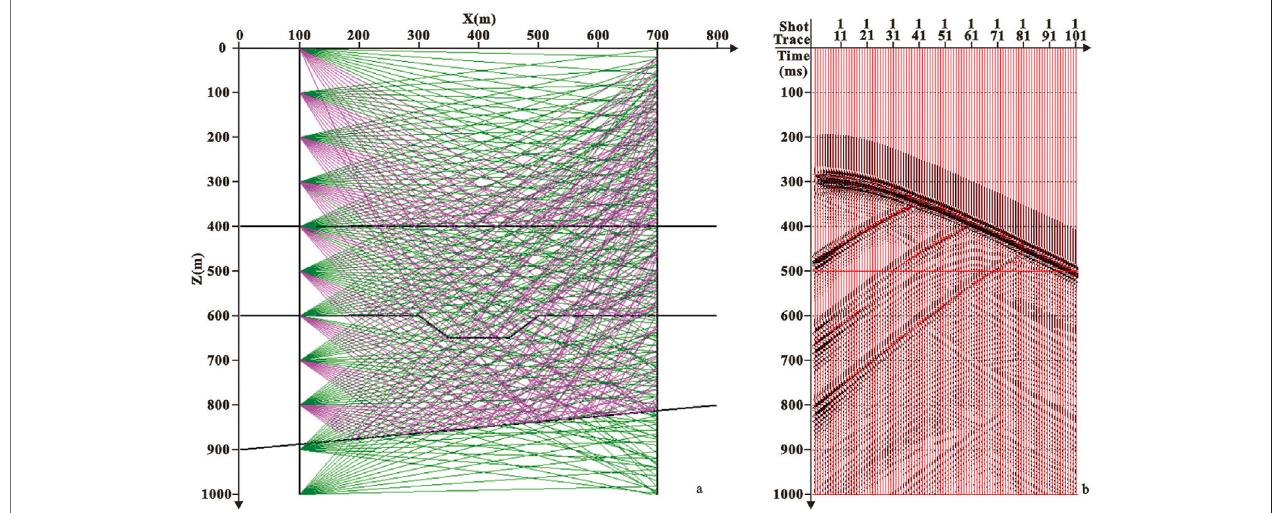
FIGURE 7 | Ray path diagram and comparison diagram of wave fi eld interaction. (A) Ray path and (B) wave fi eld interaction comparison diagram of the 1 st shot.